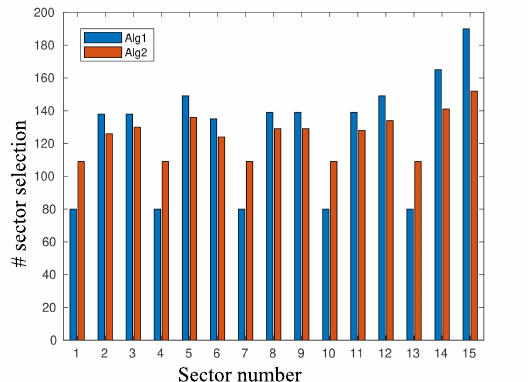
Figure 14. Sector selection distribution, where sectors 1, 4, 7, 10, and 13 are subject to blockage with β = 5.